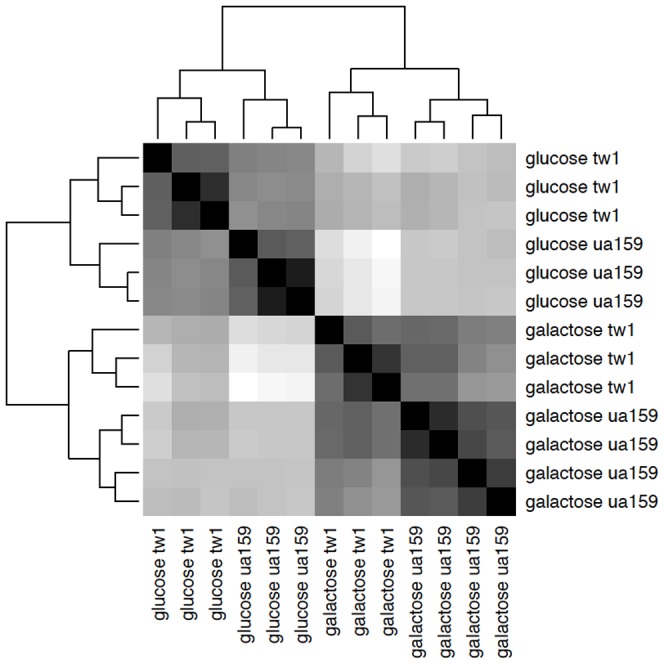
Clustering of 13 RNA-seq samples.Heatmap shows the Euclidean distances between the samples as calculated from the variance-stabilizing transformation of the count data.